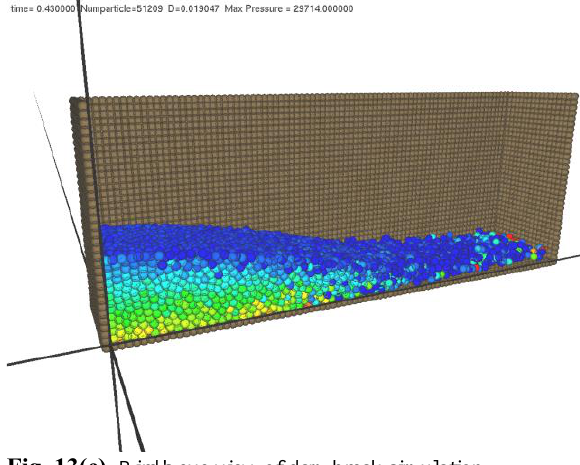
Fig. 13(c). Bird's eye view of dam break simulation (t = 0.43 sec.) .